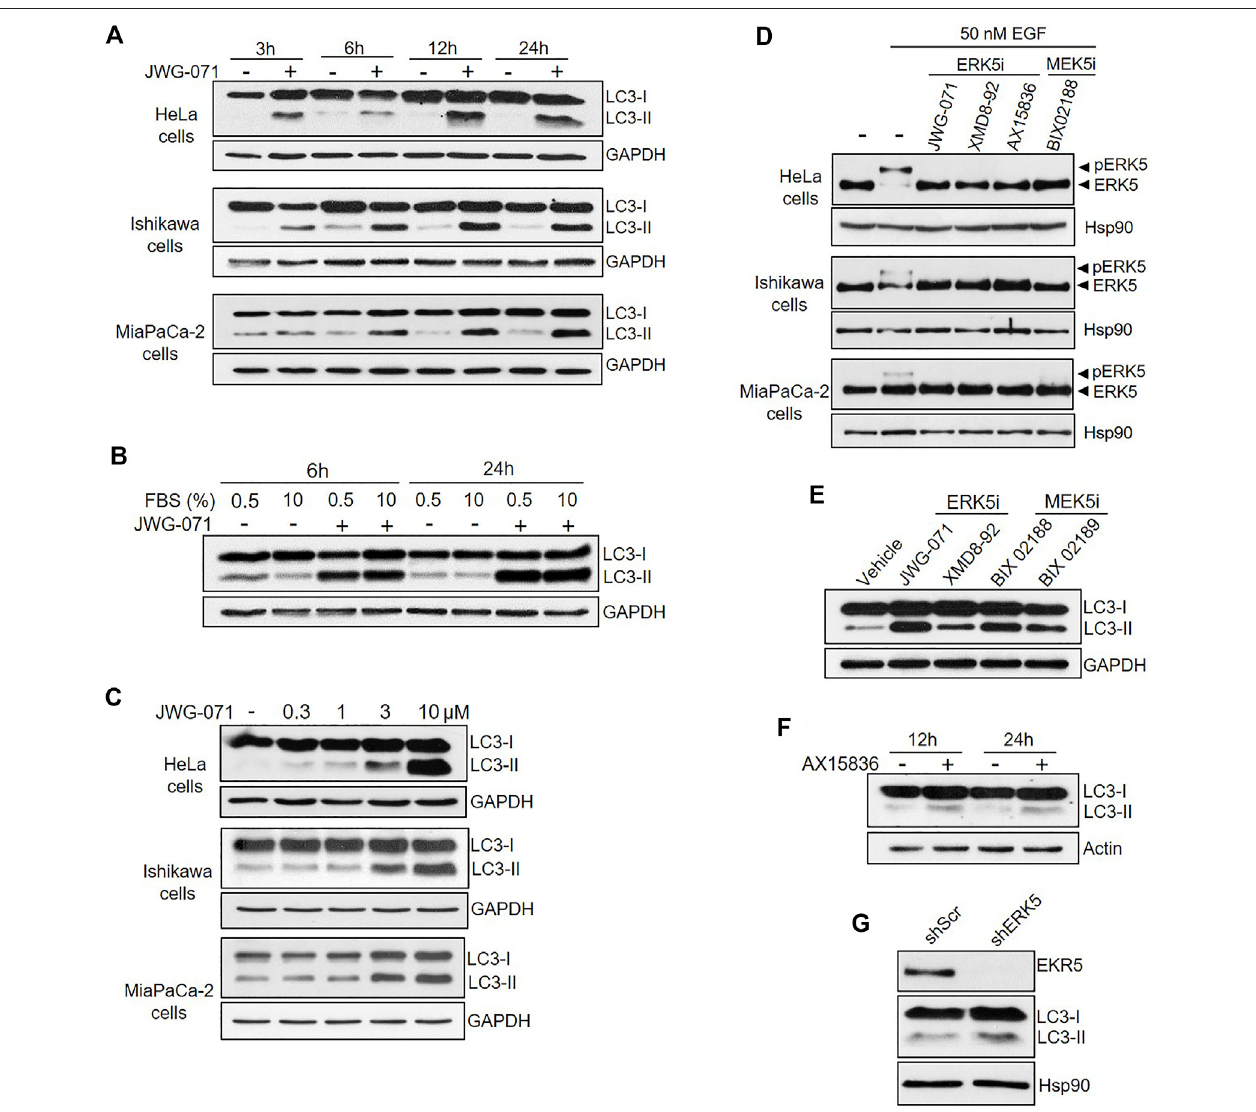
FIGURE 1 | Inhibition of MEK5/ERK5 pathway induces autophagy in serum starved and non-starved Cancer cells. (A,B) ERK5 inhibition induces sustained autophagy.Cellsunderserumstarvation(0.5%FBS), (A) orculturedwith10%FBS( B ,HelaCells)weretreatedwithvehicle(DMSO)or10 μ MJWG-071fortheindicated times. Cells were lysed and levels of the autophagy-marker protein LC3 were visualized by immunoblotting. GAPDH levels are shown as a loading control. Blots are representative of three independent experiments. (C) ERK5 inhibition stimulates autophagy in a dose-dependent manner. Serum-starved cells were treated with DMSO or the indicated concentrations of JWG-071 for 24 h, and cell lysates were analysed by immunoblot as in (A,B) . Blots are representative of two separate experiments. (D) ERK5 or MEK5 inhibition impairs cellular ERK5 activity. Serum-starved cells were treated with the indicated inhibitors (5 μ M), before incubation with 50 nM EGF for 30 min. Blots are representative of two separate experiments. (E) Inhibition of the MEK5/ERK5 pathway actives autophagy. Ishikawa cells were treated witheither ERK5 inhibitors (5 μ M JWG-071 or 10 μ M XMD8-92) or MEK5 inhibitors(10 μ M BIX 02188 or 10 μ M BIX 02189) for 24 h. Controls were treated with vehicle. Autophagy was detected by immunoblotting as in (A,B) . GAPDH levels are shown as a loading control. (F) ERK5i AX15836 induces autophagy. MiaPaCa-2 cells were treatedwith3 μ MAX15836for12or24 handautophagywasmonitored asin (A,B) .Actinlevelsareshownasaloadingcontrol. (G) ERK5silencinginducesautophagy. MiaPaCa-2cellswereinfected withlentiviralparticles encodingforshRNAsequencetotargetERK5.Levelsofindicatedproteinsweredetected byimmunoblotanalysis.